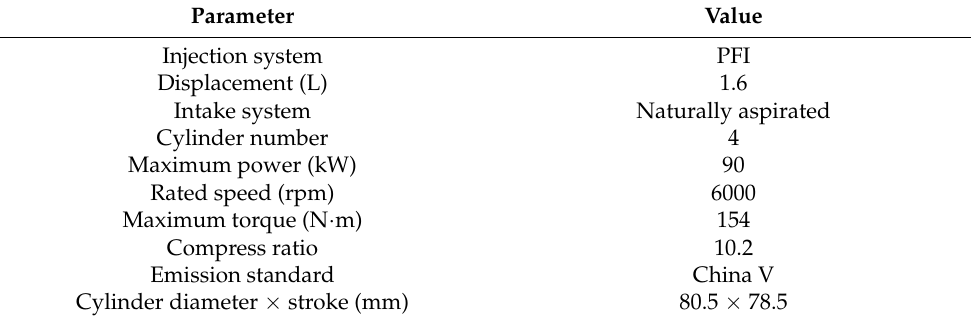
Table 1. The main vehicle